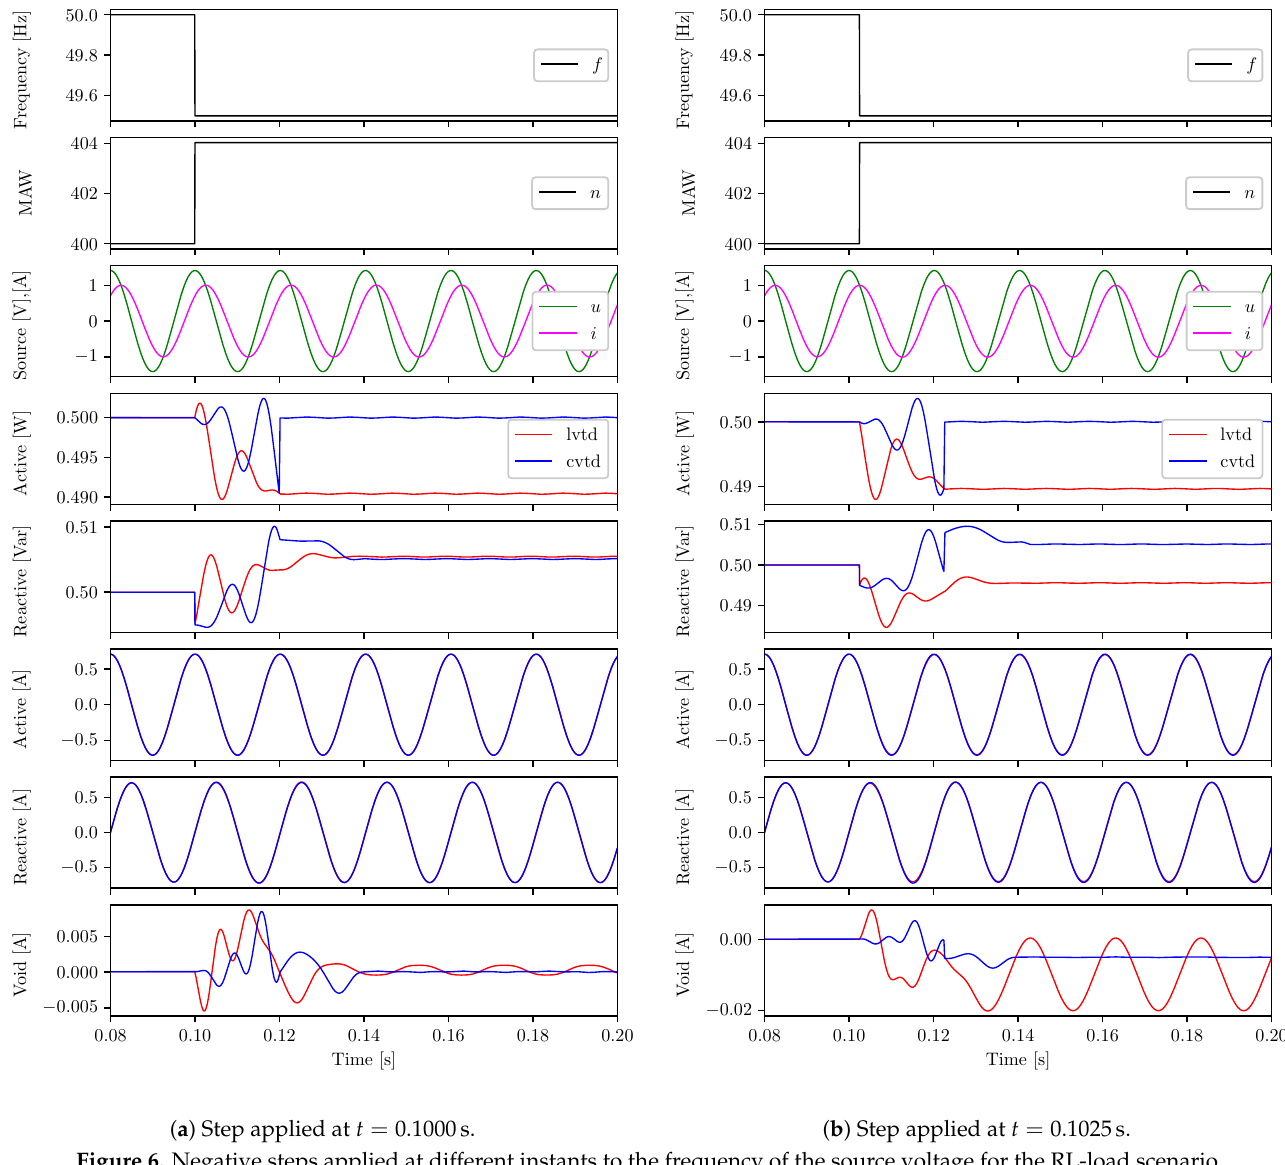
Figure 6. Negative steps applied at different instants to the frequency of the source voltage for the RL-load scenario. Frequency, MAW, and source voltage and current : in Figure 6a, the step is